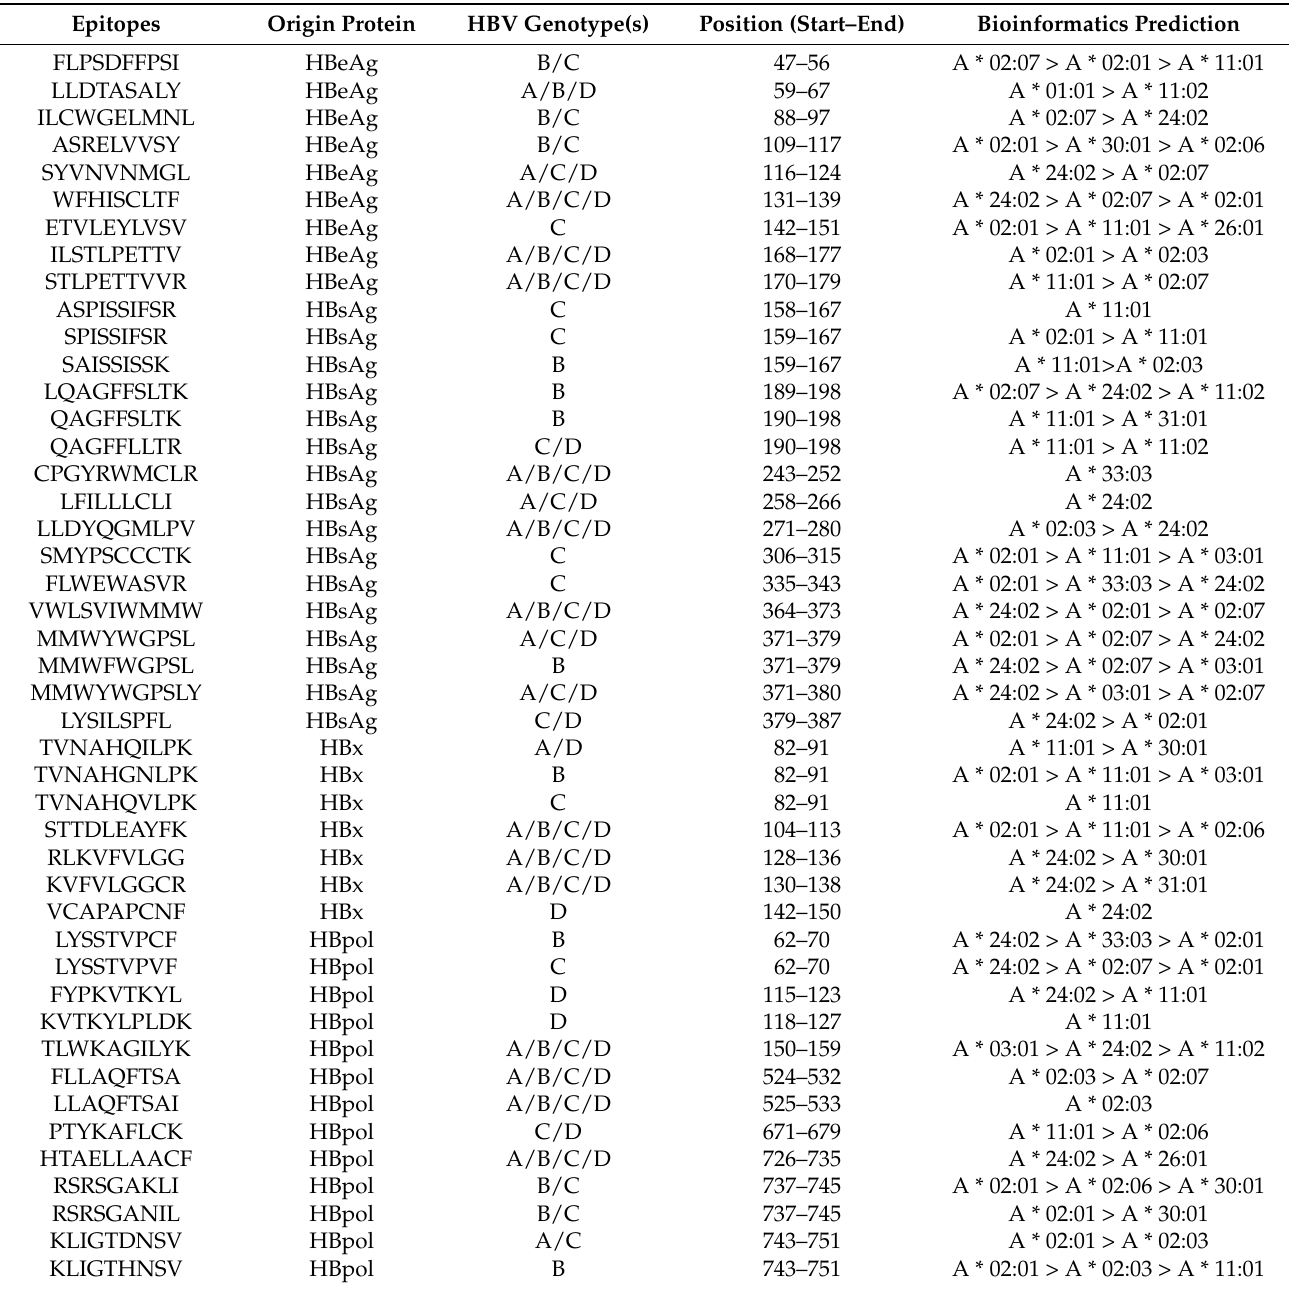
Table 6. Binding analysis of 45 HBV epitopes and HLA-A